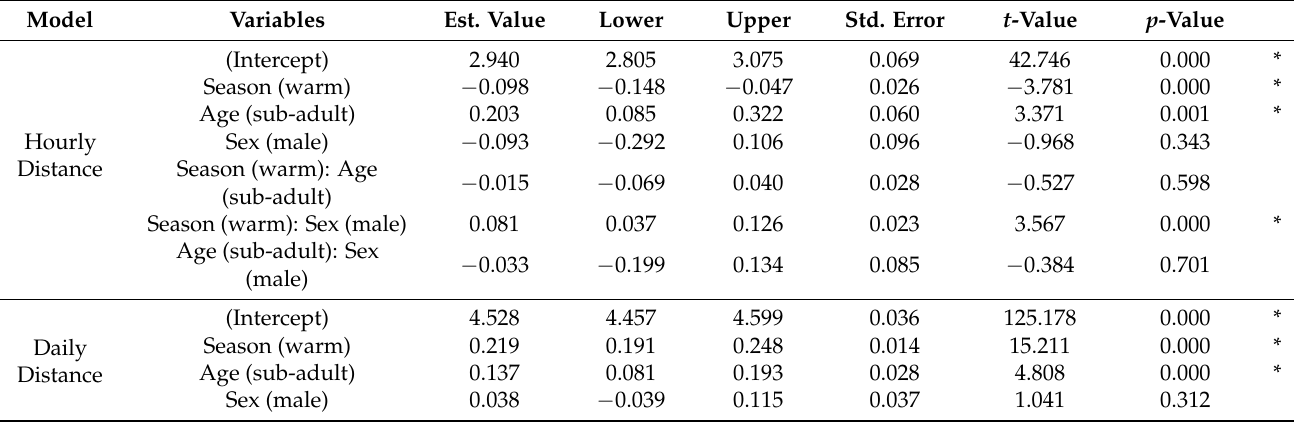
greatest daily distance flown by an immature condor was 302.2 km and was recorded in a sub - adult male condor during the warm season (ID: HECTOR) (Table S2). The mean daily distance flown was 80.5 km for all the condors, and 93.7 km was the highest mean dis- tance in an individual, recorded in a sub - adult male condor (ID: CT4072). Daily flight